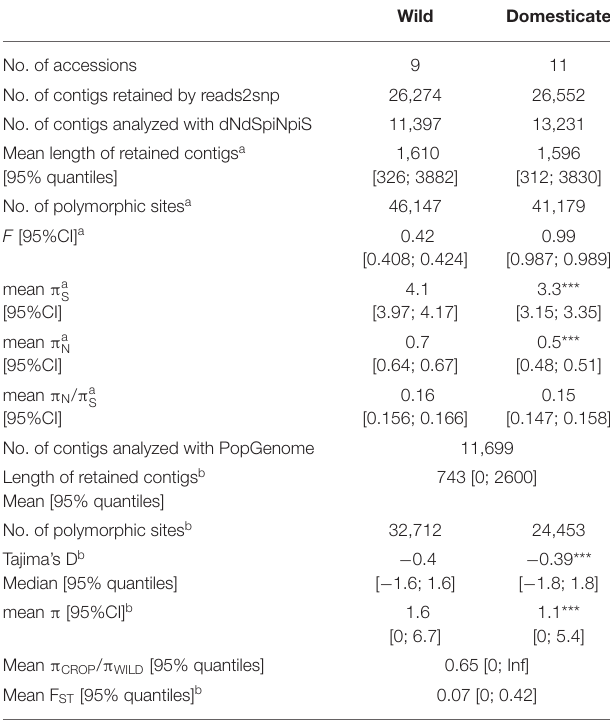
TABLE 1 | Characteristics of the data sets, coding sequence polymorphism and differentiation in wild and domesticated accessions of Sorghum bicolor